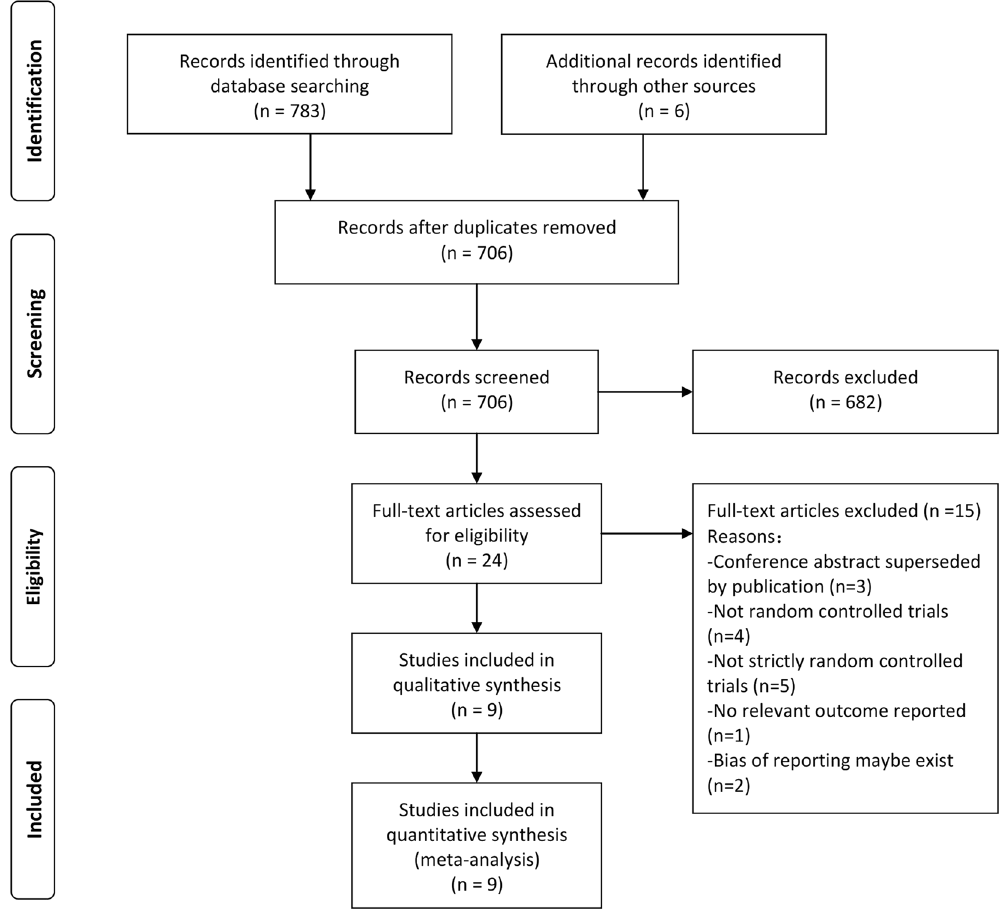
Figure 1. Article retrieval and